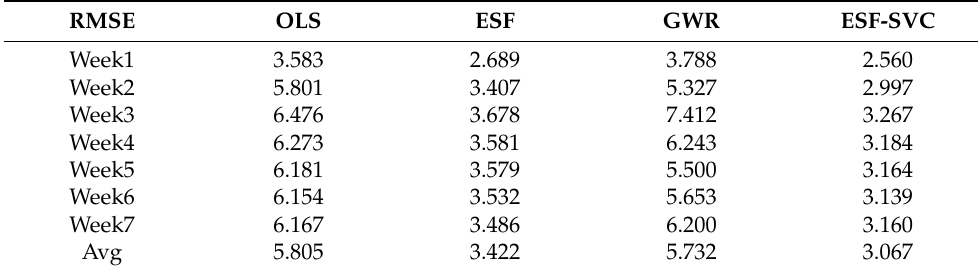
Table 11. RMSE of cross validation result (LOOCV) in mainland China. RMSE OLS ESF GWR ESF-SVC Week1 3.583 2.689 3.788 2.560 Week2 5.801 3.407 5.327 Week3 6.476 Week4 6.273